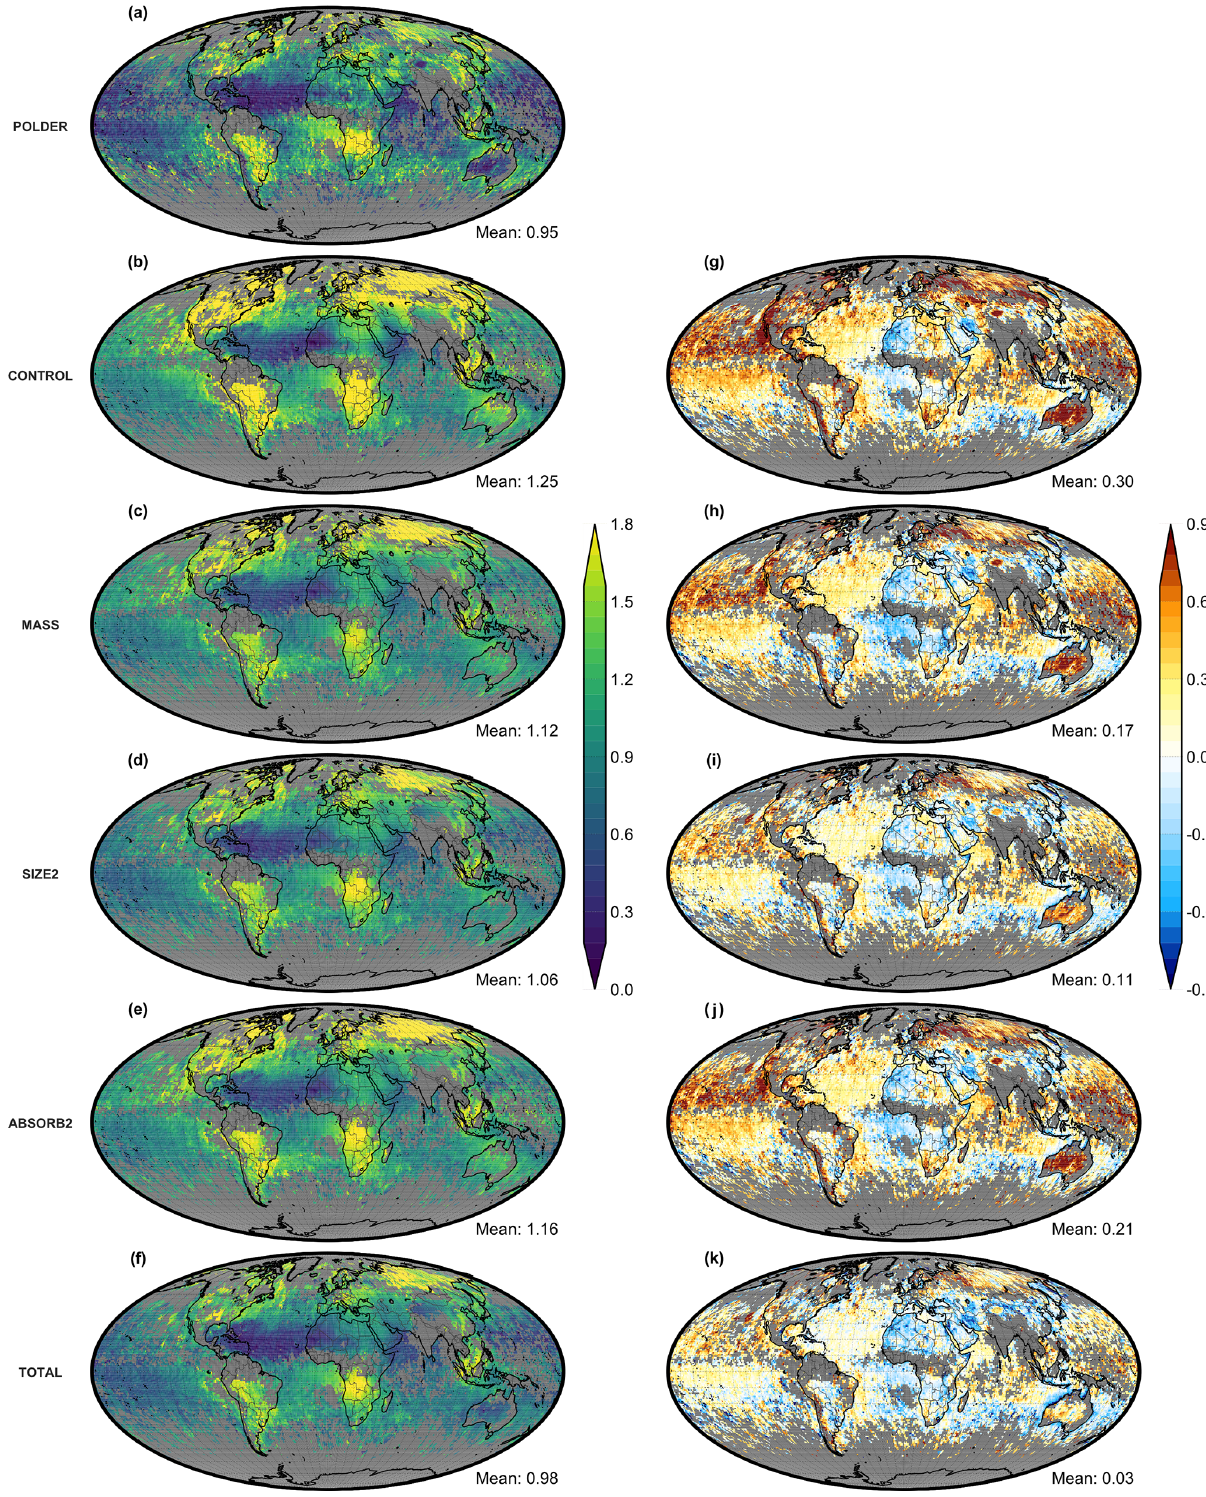
Figure 7. Similar to Fig. 5 but for the Ångström exponent at 550–865nm.